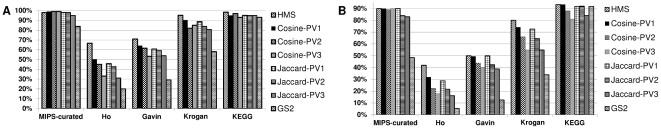
Functional coherence analysis of protein complexes and pathways.Functional coherence analysis of protein complexes from MIPS-curated [15], Ho [17], Gavin [18], and Krogan [16] as well as metabolic pathways from KEGG. Comparison between our HMS scoring, cosine similarity with different -value methods from [22], Jaccard similarity with different value methods from [22] and GS[23] methods. (A) Significant Modules (value0.05 and (B) Highly Significant Modules (value).